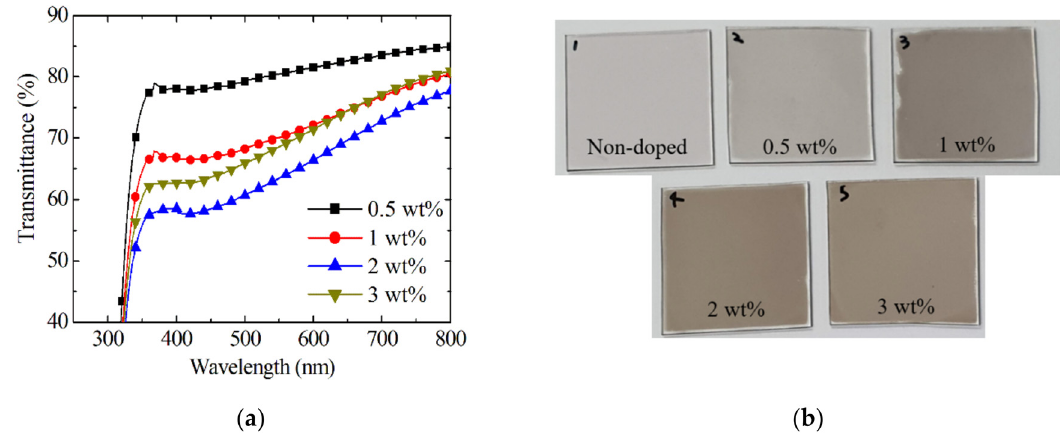
Figure 6. ( a ) Transmittance spectra and ( b ) images of Sn-doped NiO films for different Sn concentrations after 70 min UV/O 3